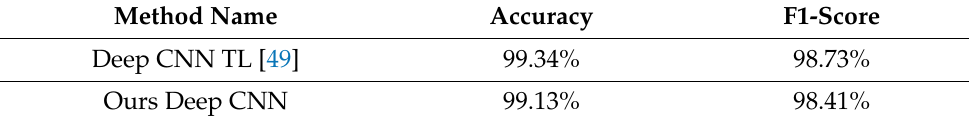
Table 7. Performance of developed ML models on SaR dog bark detection